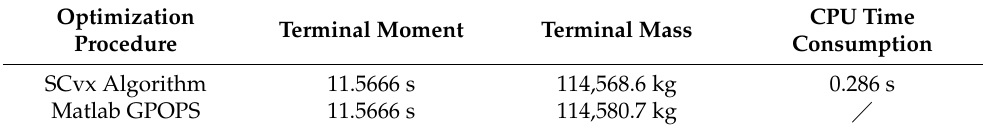
Table 3. Optimization results.